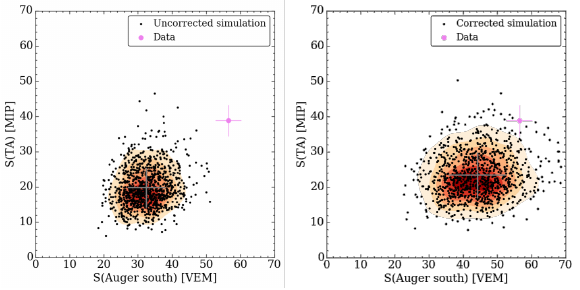
Figure 6. MIP vs VEM signal measured by the two co-located stations for the same event shown in fig. 5 (magenta point) com- pared with CORSIKA simulations using QGSJET-II.04 before (left) and after (right) correction to account for the muon excess observed in the data.